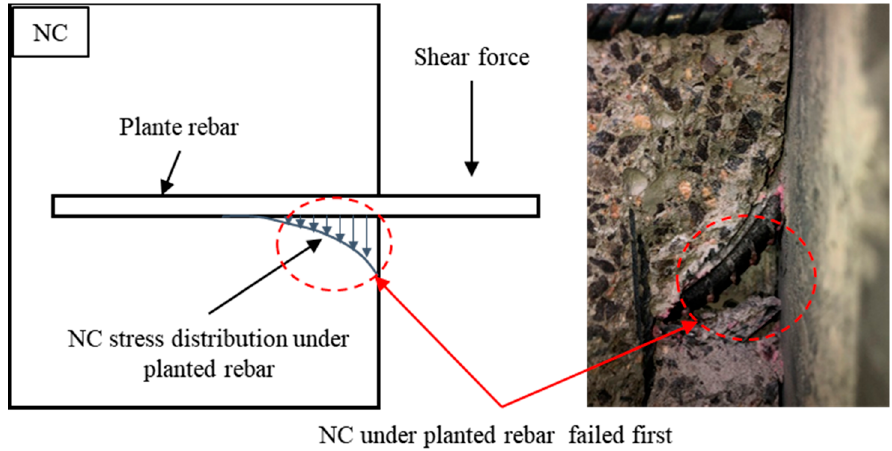
Figure 7. NC stress distribution under the embedded steel rebar.